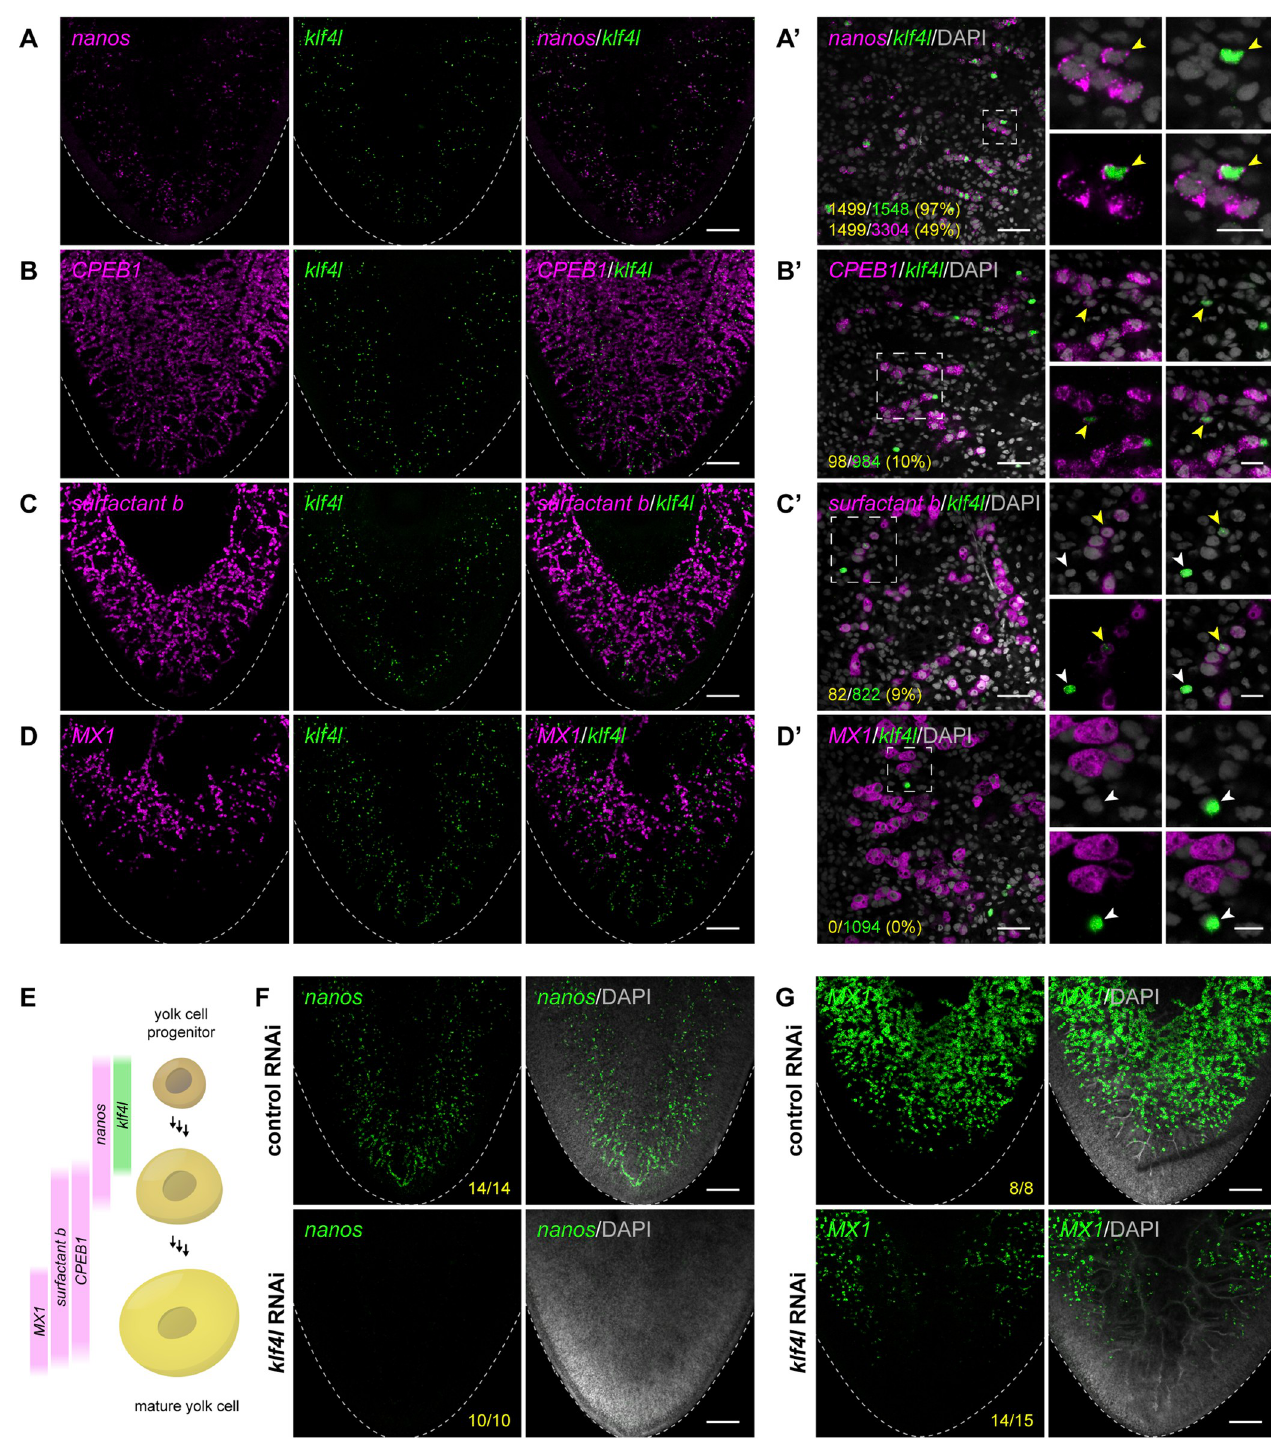
Fig 5. klf4l + cells are present in vitellaria and are the progenitors of yolk cells. ( A–D ) Maximum intensity projections of confocal sections showing dFISH of klf4l (green) with nanos ( A ), or vitellaria markers CPEB1 ( B ), surfactant b ( C ), and MX1 ( D ) (magenta) in the ventral posterior region of sexually mature planarians. Dashed line denotes planarian boundary. ( A’–D’ ) Single confocal sections of dFISH corresponding to A–D . ( A’ ) dFISH of ventrally expressed klf4l (green) and nanos (magenta). Almost all klf4l + cells coexpress nanos whereas klf4l is expressed in a subset of nanos + cells. ( B’–D’ ) klf4l is expressed in a subset of CPEB1 + ( B’ ) and surfactant b + ( C’ ) yolk cells, but not in MX1 + yolk cells ( D’ ). ( A’–D’ ) Side panels are high-magnification views of outlined areas showing klf4l single- (white arrowheads) and double-positive cells (yellow arrowheads). Note the increase in cell size as klf4l + cells differentiate into CPEB1 + ,